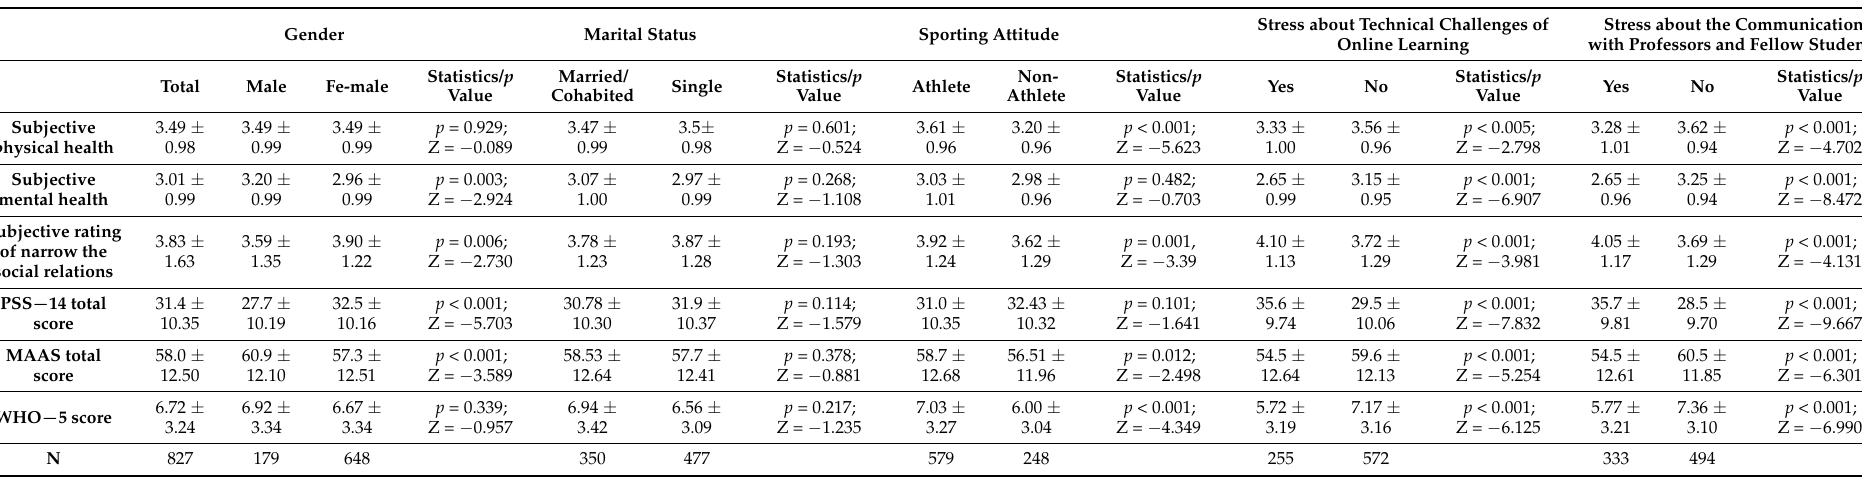
Table 1. Mean values; standard deviation; significance of MAAS, PSS-14, and WHO-5 total score; subjective physical and mental health; subjective rating of narrowing of the social relationships; stress about technical and communication changes in online courses regarding total, gender, marital status, and sporting habits. Gender Marital Status Sporting Attitude Stress about Technical Challenges of Online Learning Stress about the Communication with Professors and Fellow